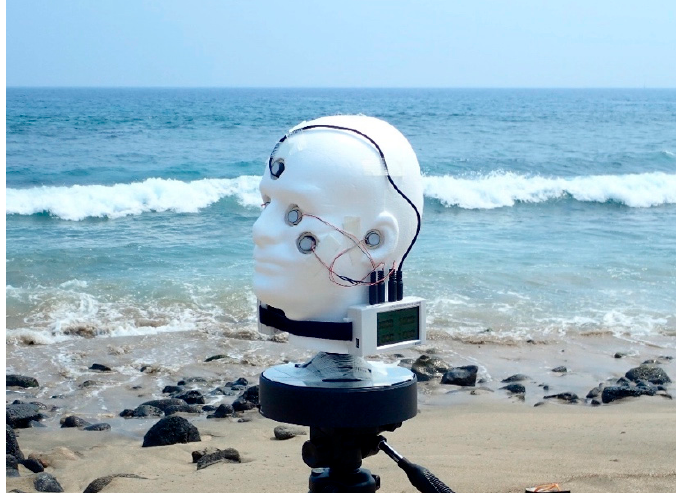
Figure 2. Mannequin head fitted with UVR sensors at ears, eyes, cheeks, and forehead mounted on a battery-powered turntable while collecting data at the Old Kona Airport Park beach (23 July 2018). Two 16-bit data loggers are attached to the head’s neck with VELCRO ® . Note the nearby surf, which scattered some low level UVR toward sensors facing the ocean.